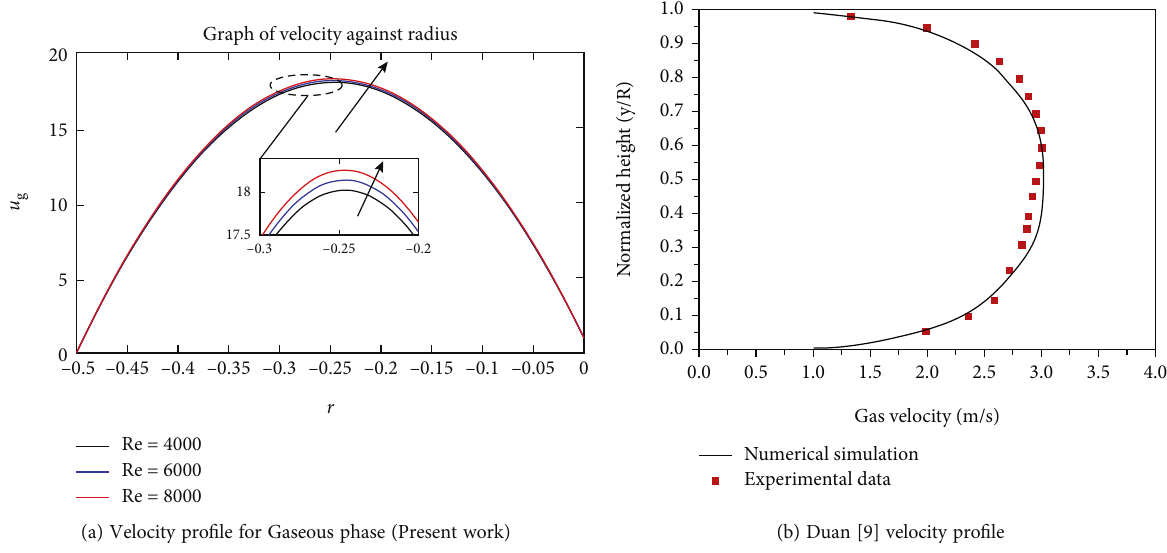
Figure 12: Comparison between Duan [9] velocity pro fi le for gaseous phase and velocity pro fi le for this